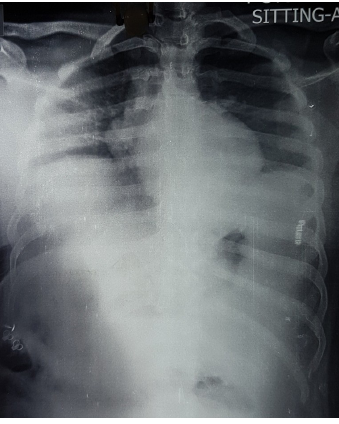
Figure 2. Chest X-Ray showing bilateral lung